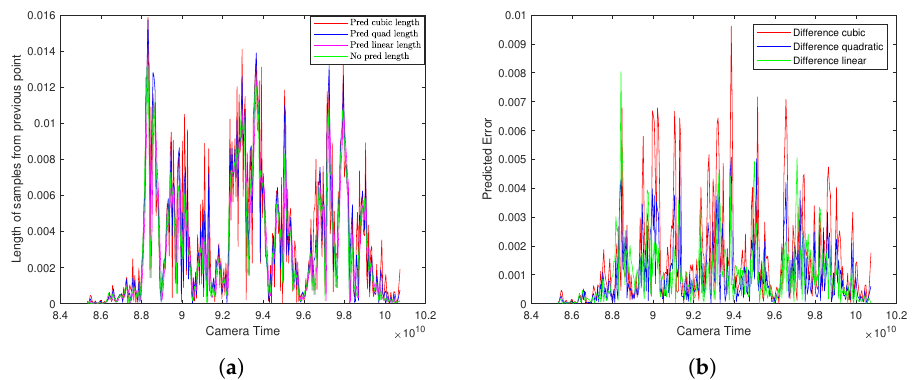
Figure 5. ( a ) Comparison of the total length of the cubic, quadratic, and linear and actual/no prediction length and ( b ) The differences of the cubic, quadratic, and linear function data from the original